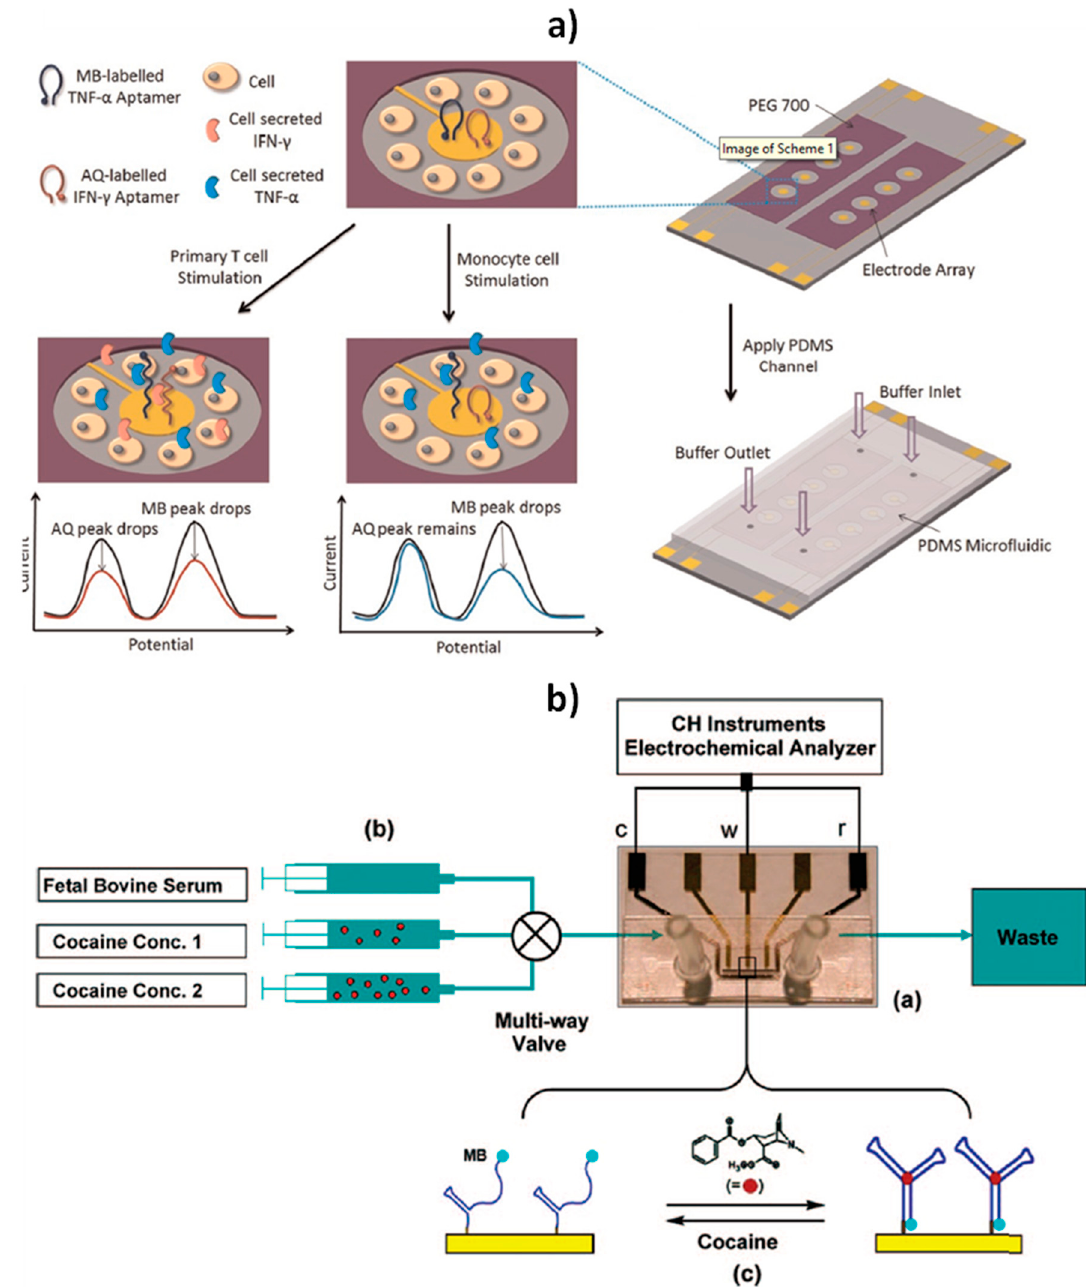
Figure 6. Schematic display of the microfluidic sensing platform using E-AB sensors for the dynamic monitoring of interferon- γ (IFN- γ ) and tumor necrosis factor- α (TNF- α ) from immune cells ( a ), and the experimental setup for the real time detection of cocaine in continuously flowing, undiluted blood serum using a E-AB sensor constructed onto a microfabricated MECAS chip ( b ). Reprinted and adapted from (a) [26] and (b) [9] with permission.